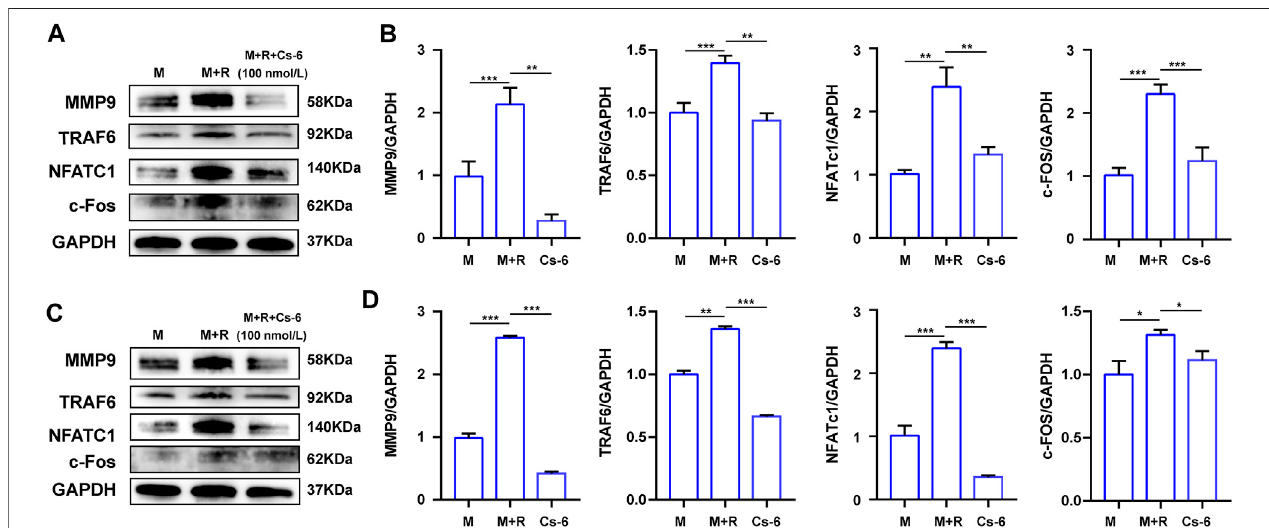
FIGURE 6 | CS-6 suppressed the protein expression of the OC marker genes. (A) The results of the protein expression of OC-related genes including TRAF6, MMP-9,c-Fos,andNFATc1inBMMcellsstimulatedwithRANKL(50 ng/ml)withindicatedconcentrationsofCS-6(100 nM)for5 – 7 dayscomparedtothecontrolgroup (30 ng/ml MCSF only). (B) The expression of related protein was quanti fi ed. (C) The results of the protein expression of OC-related genes including TRAF6, MMP-9, c-Fos, and NFATc1 in BMM cells stimulated with RANKL (50 ng/ml) for 3 days prior to indicated concentrations of CS-6 (100 nM) compared to the control group(30 ng/mlMCSFonly). (D) Theexpressionofrelatedproteinwasquanti fi ed.Valueswerepresentedasthemean ± standarddeviation( n (cid:2) 3);* p < 0.05,** p < 0.01, *** p < 0.001, **** p <